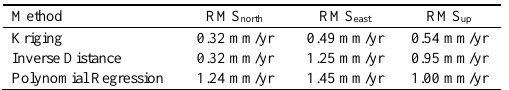
Table 5. Velocity comparison between derived and published